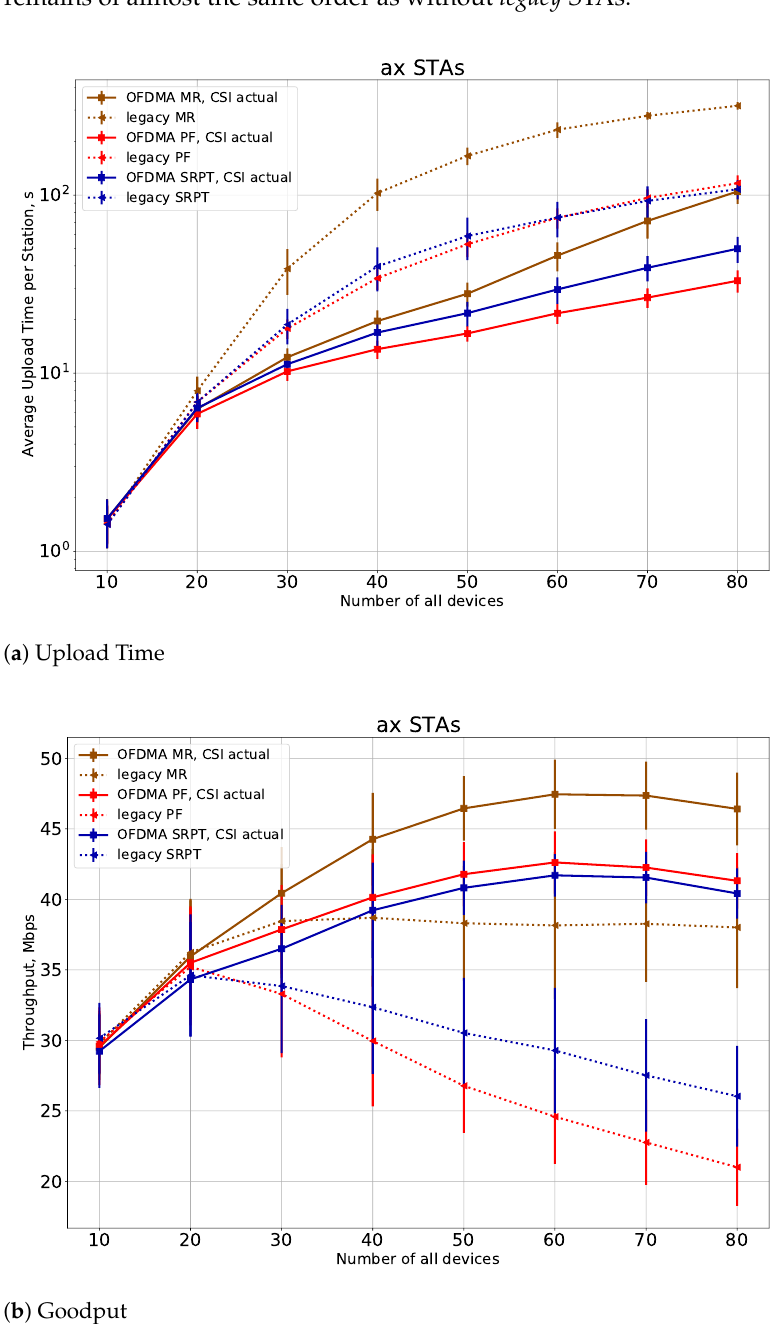
Figure 6. ( a ) Upload time and ( b ) goodput of the ax STAs if the half of all devices are legacy . In the third series of experiments, we check the efficiency of the CSI Adaptation Algorithm (see Section 6). The results are shown in Figure 7 for different variants of the greedy-PF scheduler. We consider the cases with T fd = 0 s, i.e., when the APs always have actual information about the channel, and the T fd = 0.5 s, i.e., when fading information is updated every 0.5 s. Lines “tune” and “no tune” indicate whether the CSI Adaptation Algorithm is used or not, respectively. From the results, we can see that the adaptation gives a significant performance advantage both in terms of the average upload time and